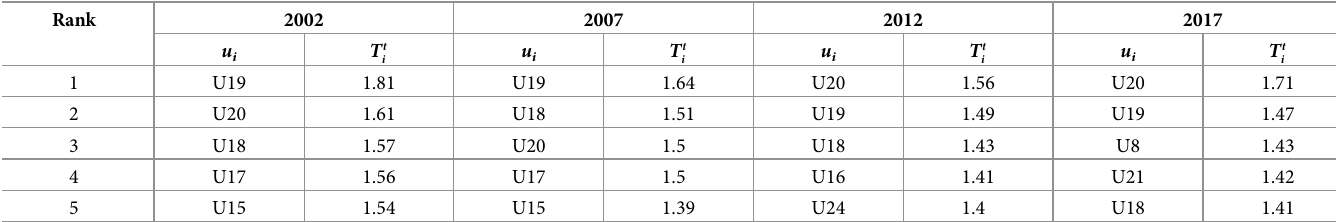
Table 5. Top 5 industries with influence coefficient.